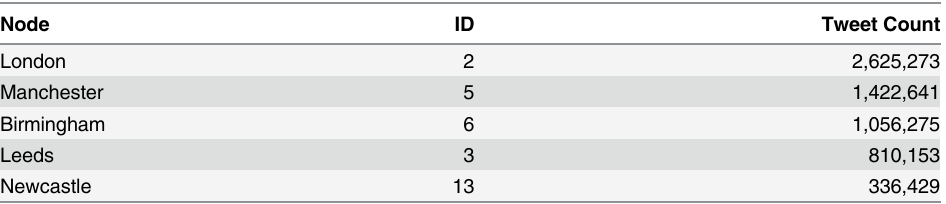
Table 4. Top 5 nodes sorted by Tweet Count.